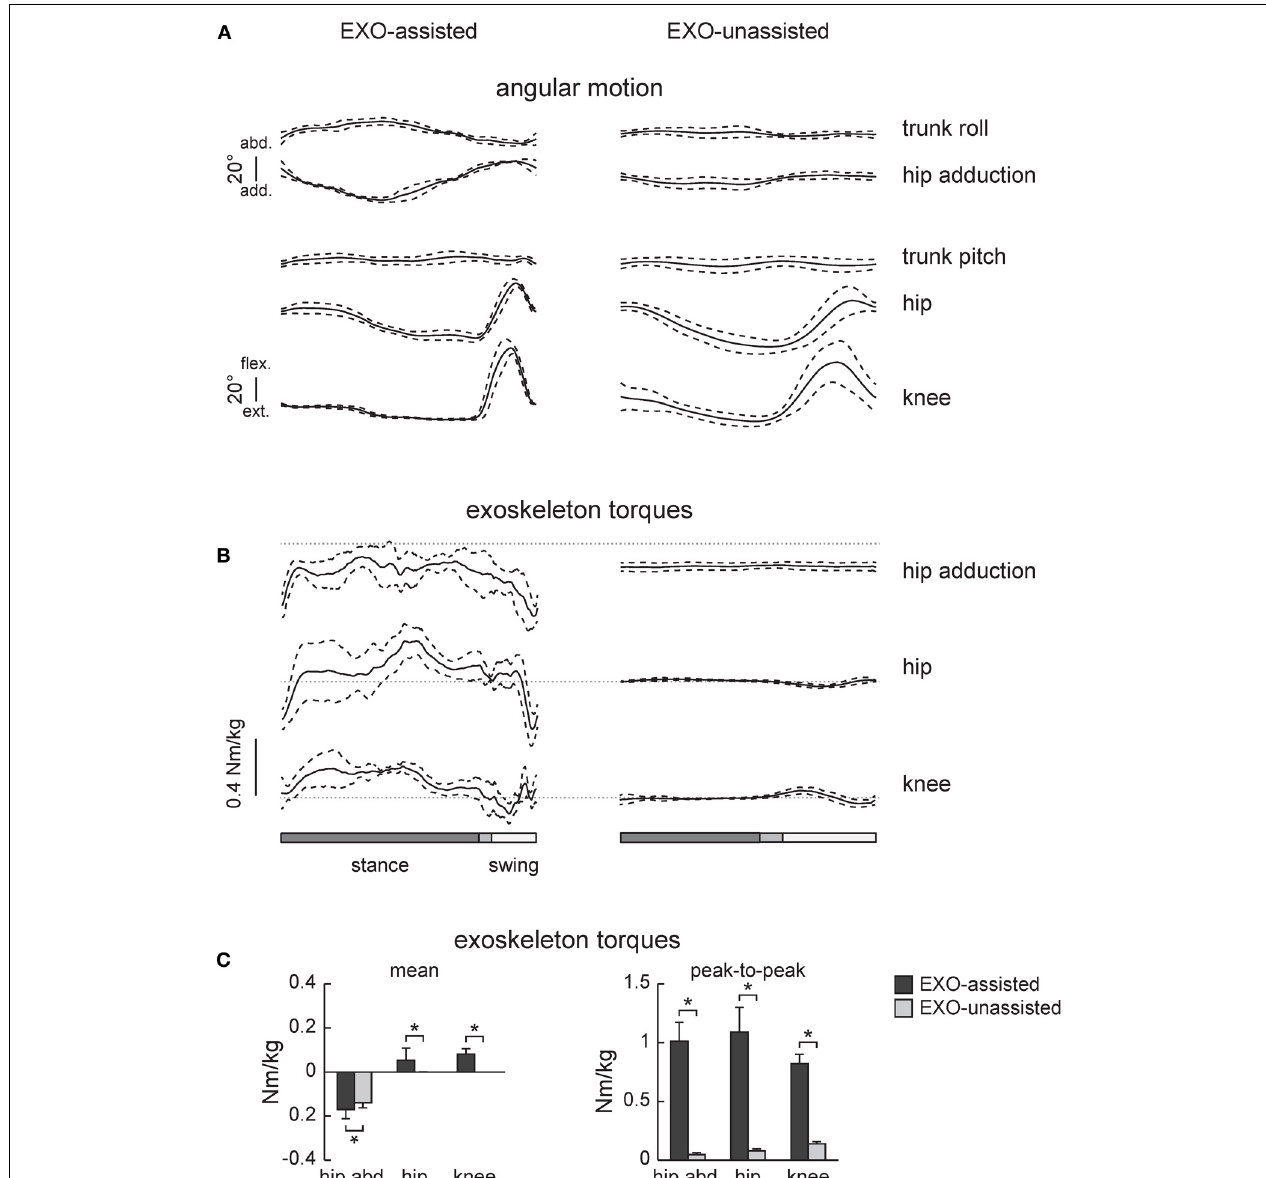
FIGURE 2 | Joint angles and exoskeleton torques recorded in healthy subjects during walking in the exoskeleton (EXO-assisted and EXO-unassisted). (A) Ensemble-averaged (mean ± SD , n = 6) joint angular movements. (B) Ensemble-averaged joint torques recorded in three powered